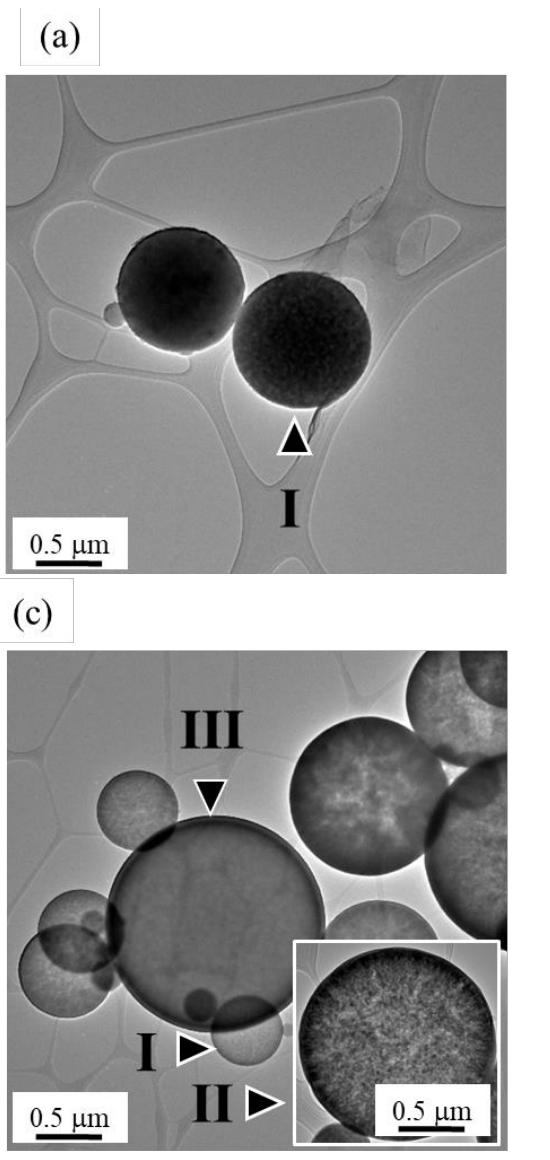
Figure 3. TEM images of ( a ) un-treated BG particles and ( b ) 0.1 M, ( c ) 0.3 M, and ( d ) 0.5 M PEG-treated BG particles. (Type I, Type II, and Type III represents solid, porous, and hollow particles). Based on the statistical measurements from SEM and TEM images, the relative fractions of three distinct morphologies (solid, porous, and hollow) of all BG particles are shown in Figure 4. First, the un-treated BG particles have a single moprhology of a solid structure (the population of Type I is 100%). Second, unlike the un-treated BG case, three types of morphology have been found in all PEG- treated BG particles. For the 0.1 M PEG-treated specimen, the populations of Types I, II, and III are 22.4 ± 2.2%, 29.9 ± 3.2%, and 48.3 ± 0.9%, respectively. For the 0.3 M PEG-treated specimen, the populations of Type I, II, and III are 15.2 ± 1.2%, 31.9 ± 1.6%, and 52.3 ± 1.0%, respectively. For the 0.5 M PEG-treated specimen, the populations of Types I, II, and III are 11.8 ± 1.2, 26.8 ± 1.6, and 61.3 ± 1.3%, respectively. In addition, all p-values are lower than 0.05, which shows a distinct difference between un-doped and PEG-doped specimens. Furthermore, it can be seen from the graph that the population of solid particles (Type I) decreases with the increase of PEG concentration (100% for un- treated BG, and 22.4 ± 2.2%, 15.2 ± 1.2%, and 11.8 ± 1.2% for 0.1 M, 0.3 M, and 0.5 M PEG-treated BG), whereas Type III populations increase when the PEG concentration increases (0% for un-treated and 48.3 ± 0.9%, 52.3 ± 1.0%, and 61.3 ± 1.3% for 0.1 M, 0.3 M, and 0.5 M PEG-treated BG) respectively,